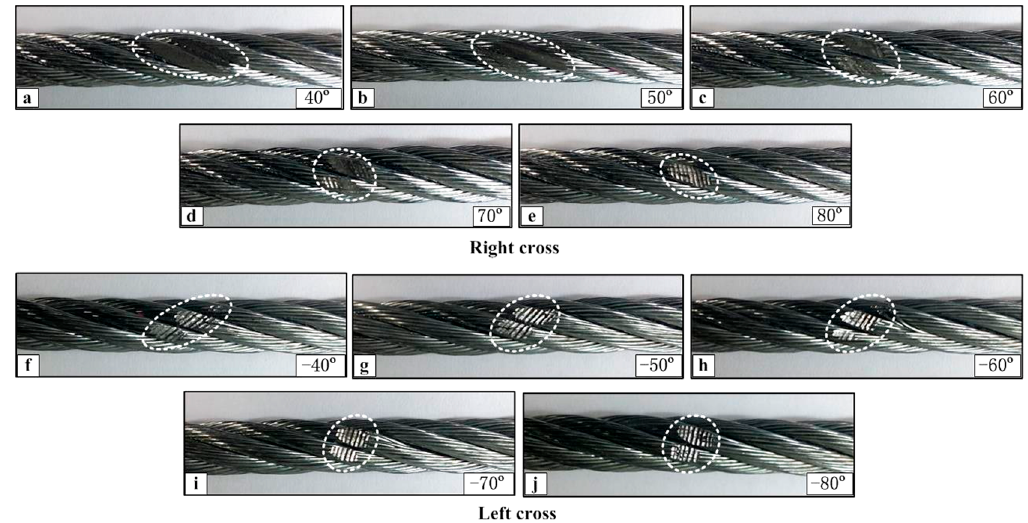
Figure 12. Wear scar pictures of the upper loading rope for a large crossing angle under different sliding conditions ( x : 20 mm; v : 12 mm/s). ( a – e ): Right cross contact; ( f – j ): left cross contact. The wear scar regions are marked by the dashed lines.